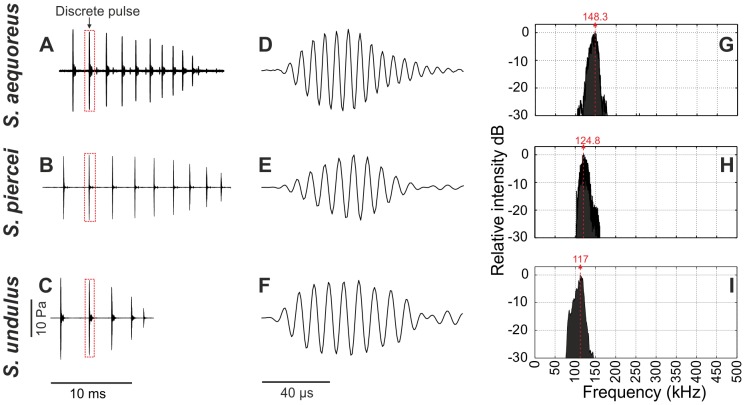
Calling song features of Supersonus spp.(A–C) Syllable or pulse train produced during a closing stroke of wing motion. (D–F). Wave form of a discrete pulse (red rectangle in A, B, and C). (G–I). Power spectrum.